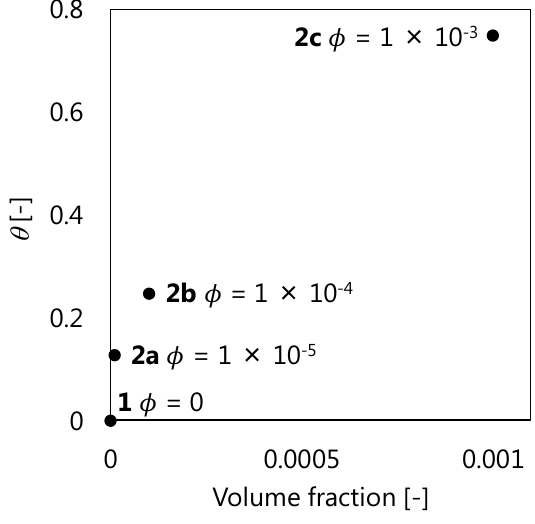
Figure 6. Relationships between volume fraction of magnetic nanoparticles (MNPs) and